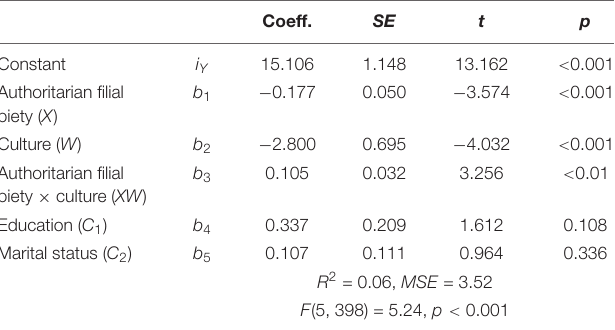
TABLE 5 | Summary of regression analysis examining the moderation effect of culture on the relationship between authoritarian filial piety and palliative care knowledge.